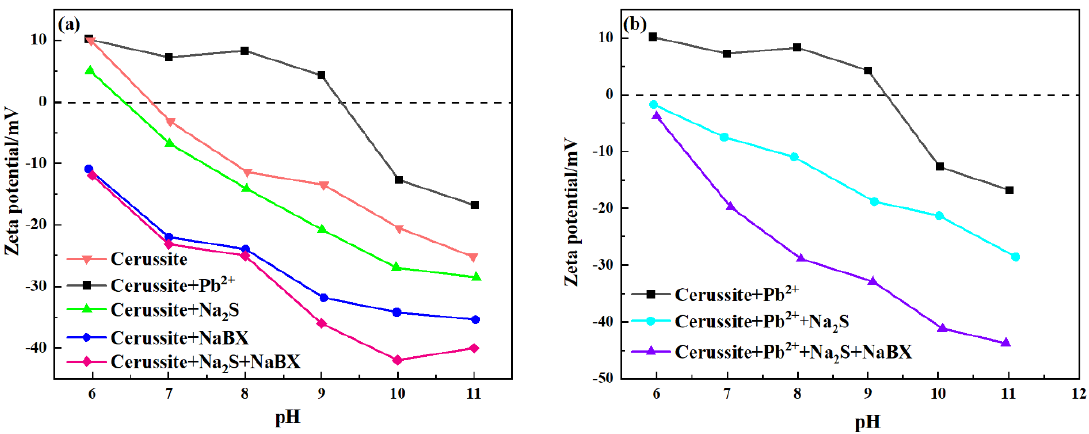
Figure 5. Zeta potential of ( a ) cerussite and ( b ) sulfidized cerussite as a function of pH in the presence or absence of lead ions.